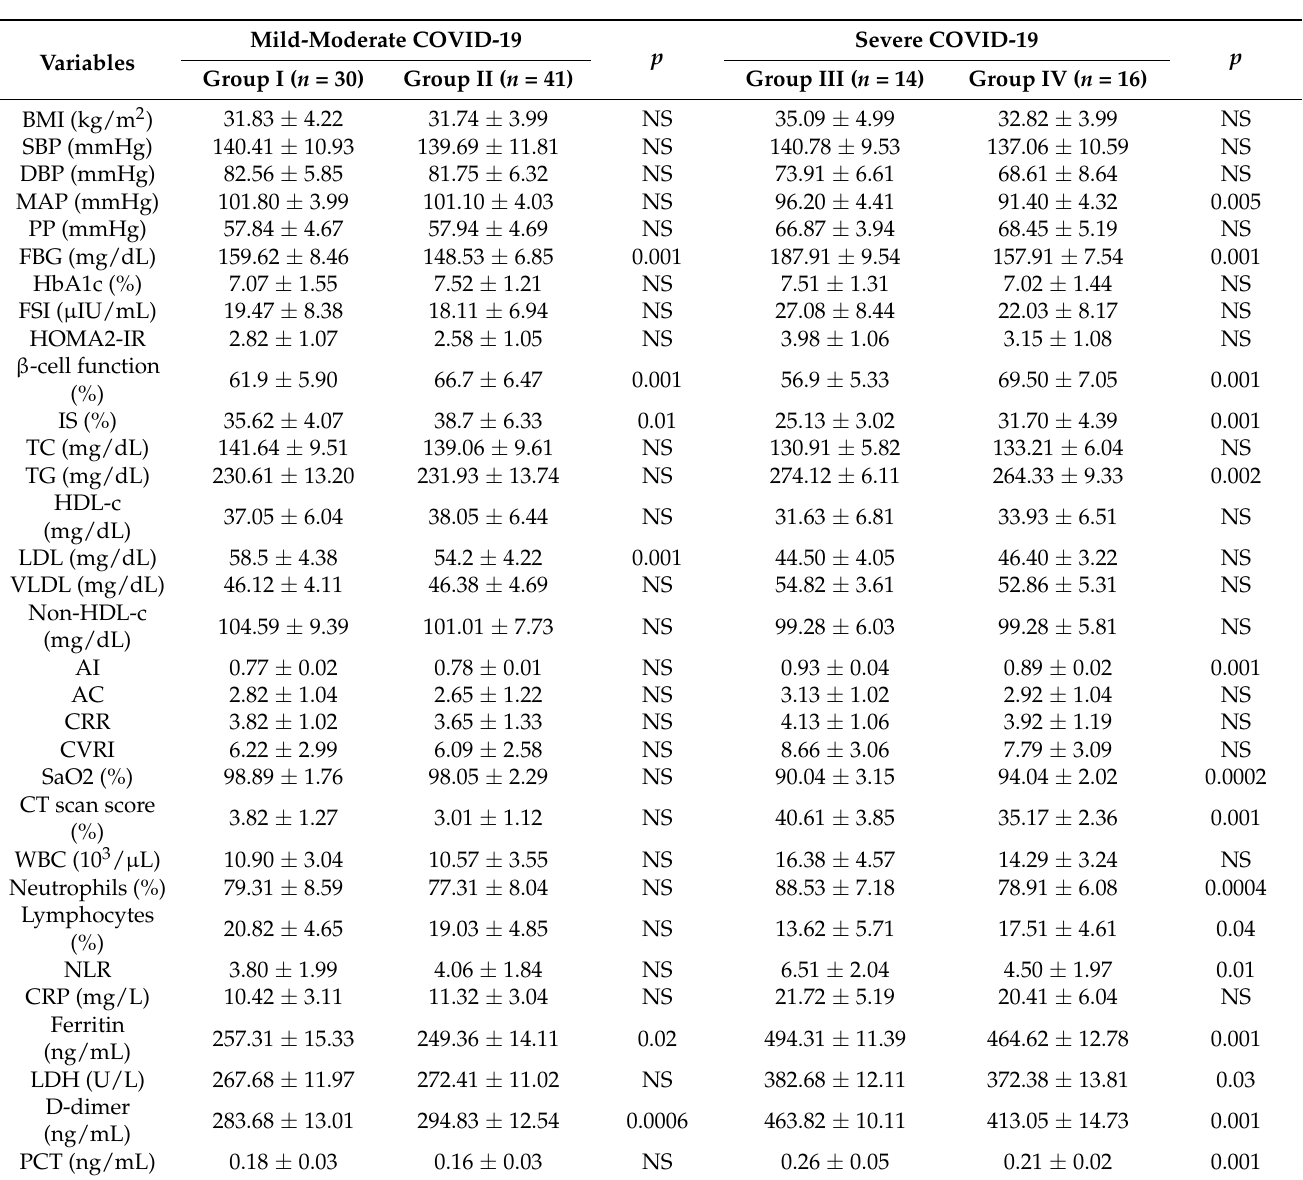
Table 3. Impacts of metformin and metformin plus sitagliptin on the anthropometric and biochemical variables in T2DM patients with